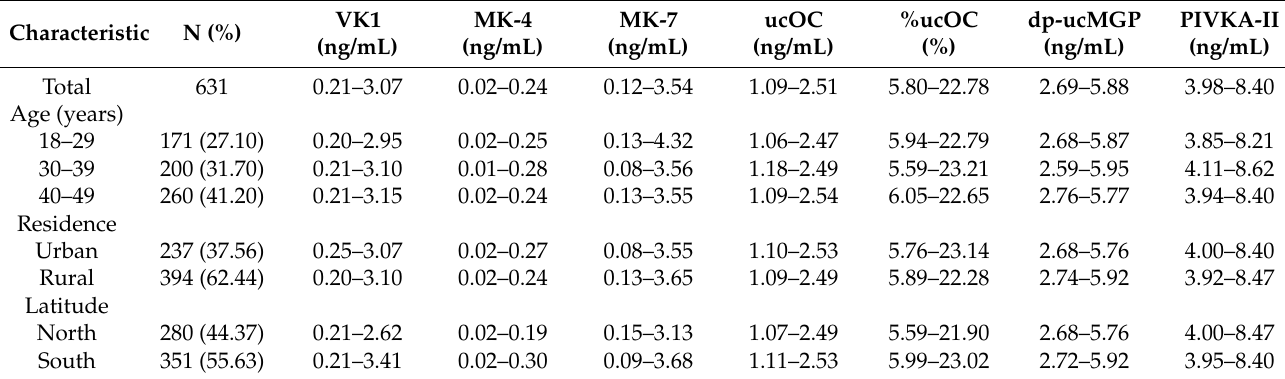
Table 5. Reference range for vitamin K evaluating indicators (P2.5–P97.5).